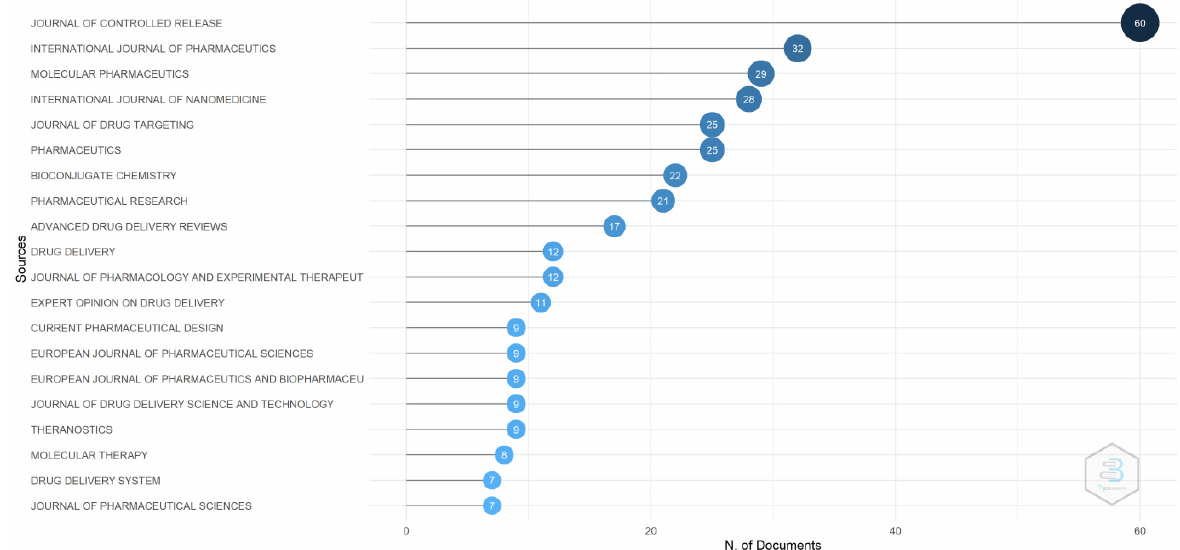
Figure 8. Most relevant sources. Source: Authors’ elaboration using the Bibliometrix R-package.